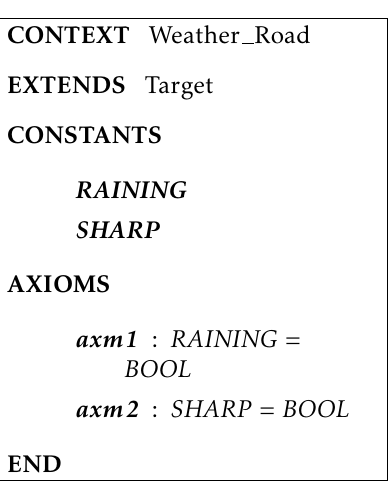
Figure 8. Extended context for ACC